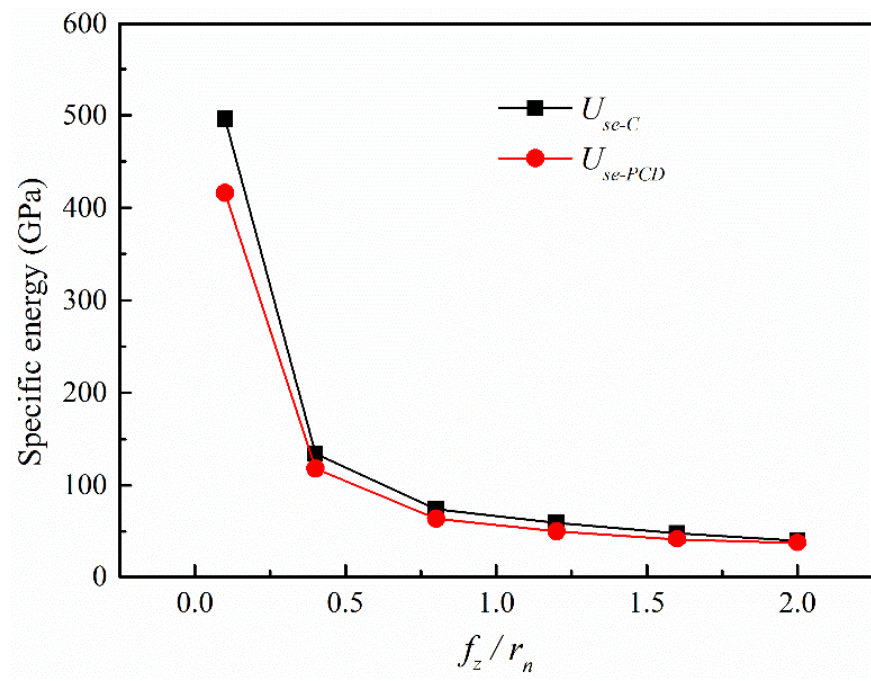
Figure 8. Variation of specific energy with varying f z / r n .